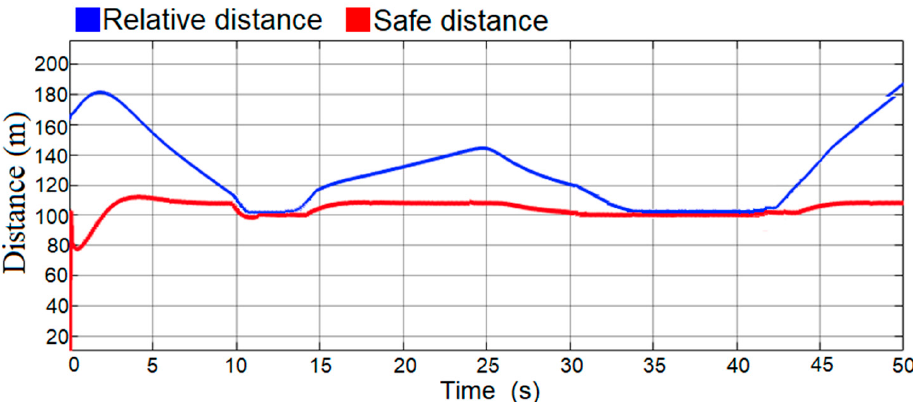
Figure 18. Relative distance and safe distance (results from simulation).